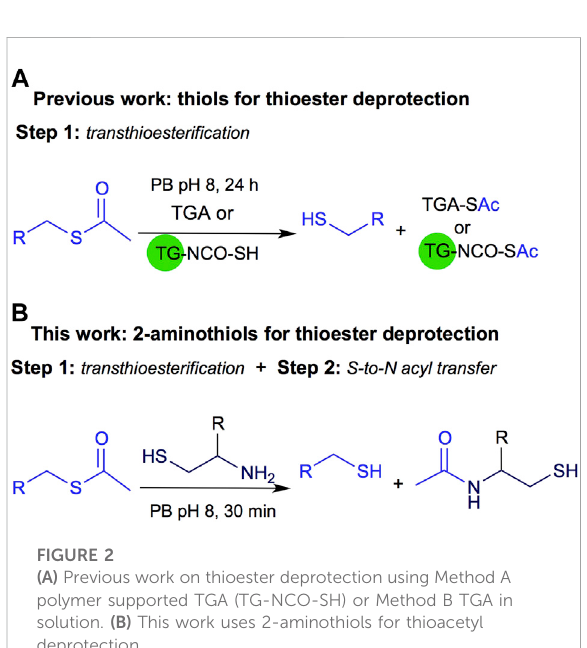
FIGURE 2 (A) Previous work on thioester deprotection using Method A polymer supported TGA (TG-NCO-SH) or Method B TGA in solution. (B) This work uses 2-aminothiols for thioacetyl